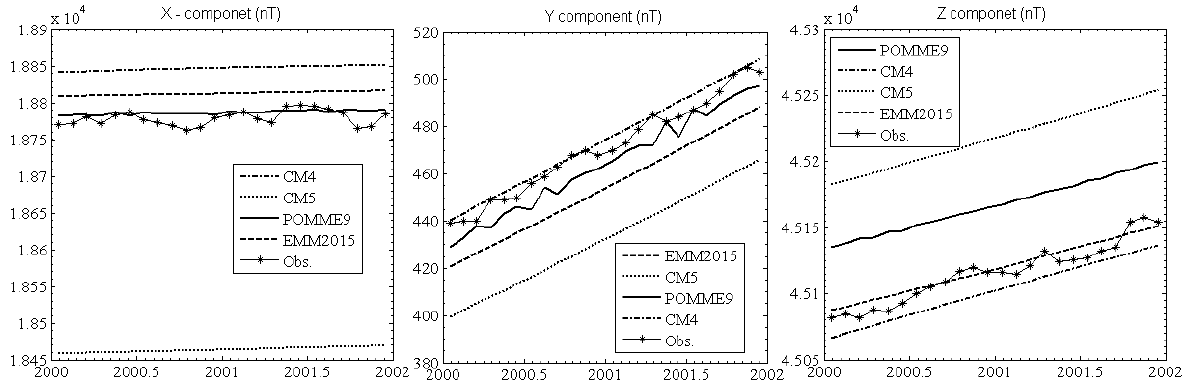
Figure 1. Comparison of short monthly series of geomagnetic field observed at NGK observatory and predicted by different models (CM4, CM5, POMME-9,